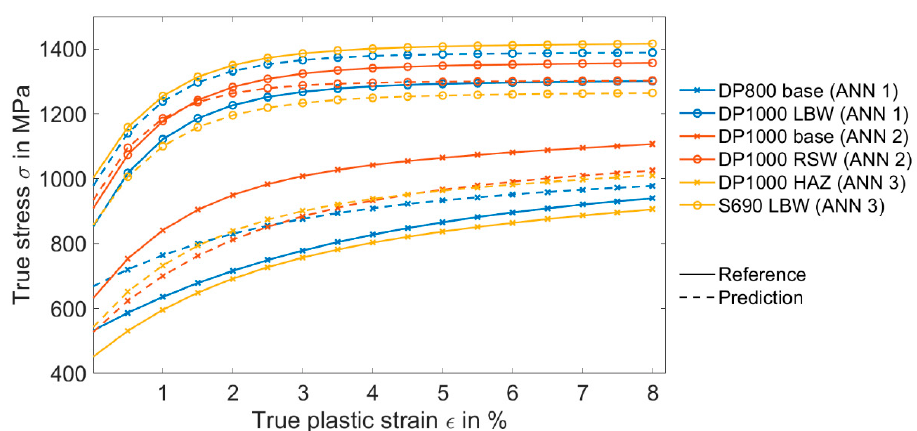
Figure 10. Comparison between the output of the ANN and the reference values from Table 4, where the ANN trained with the features extracted from images shows the deformation of the indented surface (3D-measurement image). surface (3D-measurement image).